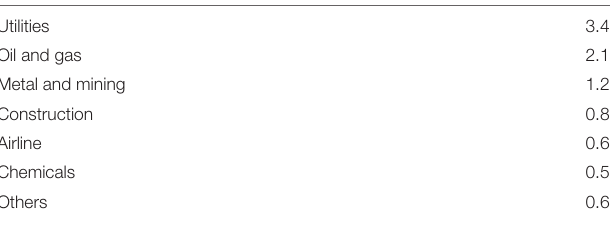
TABLE 2 | Main sources of carbon in 2018 [gigatonnes of carbon dioxide (CO 2 ) equivalent].